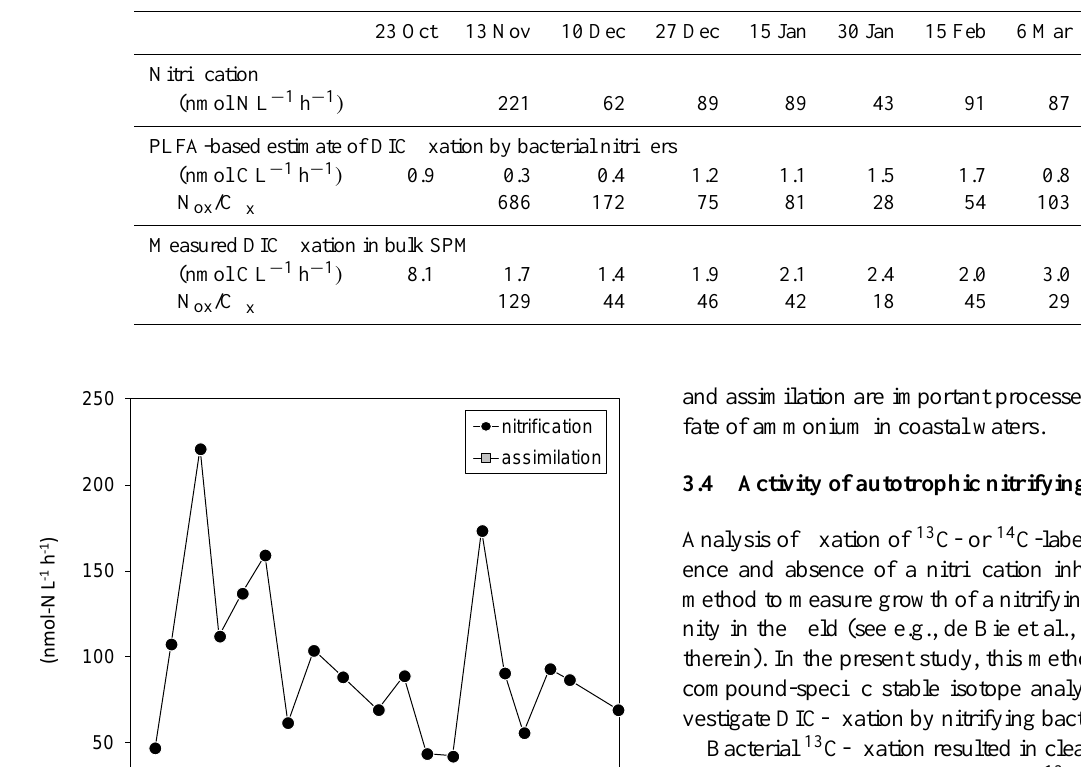
Table 1. Rates of nitrification and DIC fixation with corresponding N ox /C fix ratios. See text for details.